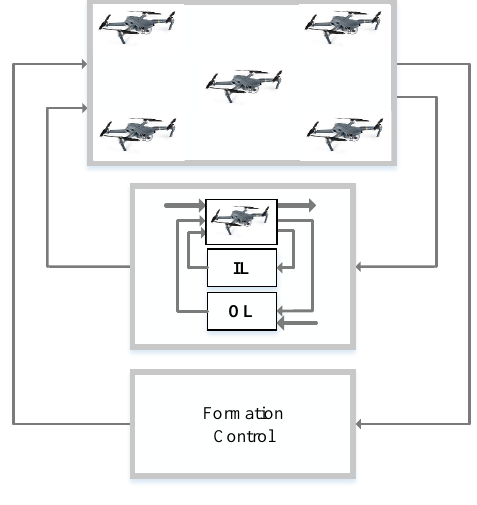
Figure 4. The flight control system for multiple